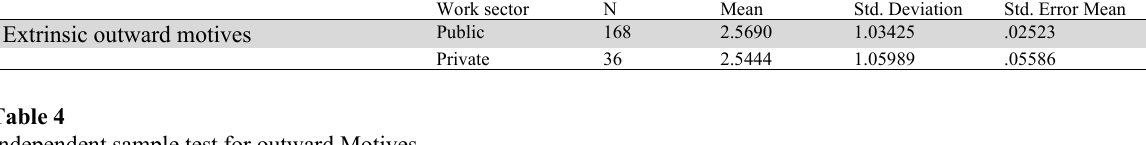
Group Statistics for Outward Motives